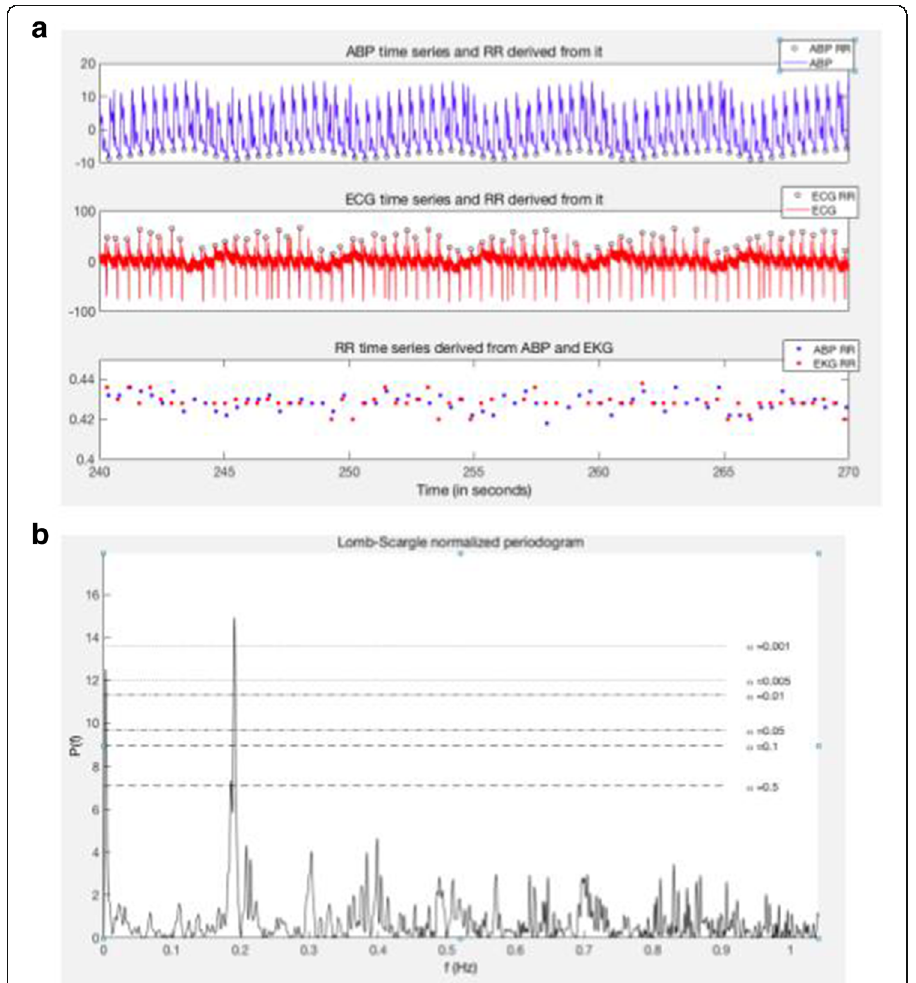
Fig. 2 Heart rate variability. Temporal and spectral representation of 6-s-long ECG segment ( t = 240 to 270 s) for pig 9 (file 25) showing: a the zero-centered ABP time series (blue in mmHg) with detected R peaks indicated with black circles, the zero-centered inverted ECG time series (red in mV) with detected R-peaks indicated with black circles and the resulting RR-interval time series for peak detection methods. b The Lomb-scale normalized perio-cardiogram derived from the ECG RR-interval time series showing the peak at 0.2 Hz induced by mechanical ventilation set at 15 cycles per